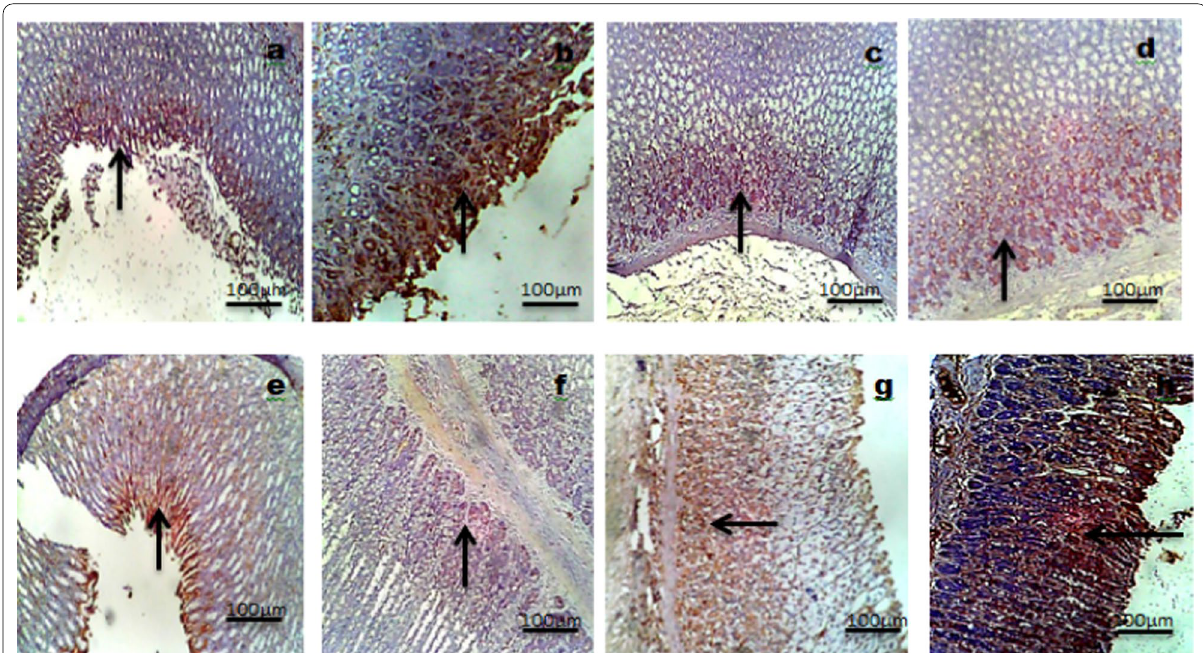
Fig. 18 IHC slides for evaluation of Factor VIII positive immunoreactive cells during healing of acetic acid stomach ulcer pretreated with folic acid and omeprazole. (H&E, X100). a Acetic acid stomach ulcer untreated (Day 5). b Acetic acid stomach ulcer treated with 2 mg/kg Folic acid (Day 5). c Acetic acid stomach ulcer treated with 3 mg/kg Folic acid (Day 5). d Acetic acid stomach ulcer treated with Omeprazole (Day 5). e Acetic acid stomach ulcer untreated (Day 10). f Acetic acid stomach ulcer treated with 2 mg/kg Folic acid (Day 10). g Acetic acid stomach ulcer treated with 3 mg/kg Folic acid (Day 10). h Acetic acid stomach ulcer treated with Omeprazole (Day 10). Black arrow: Point of